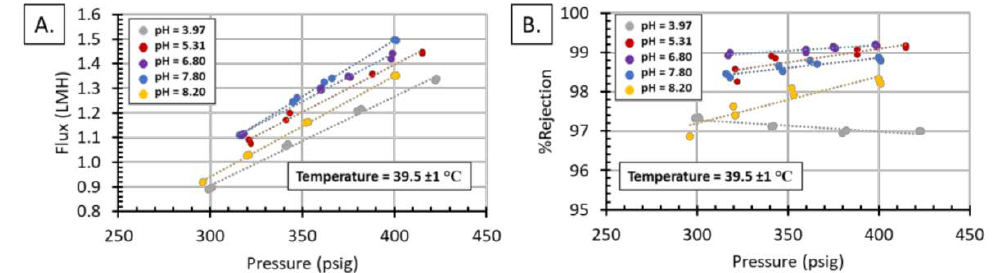
Figure 10. Effects of pressure and pH on: ( A ) water flux and ( B ) %rejection for FGD wastewater.